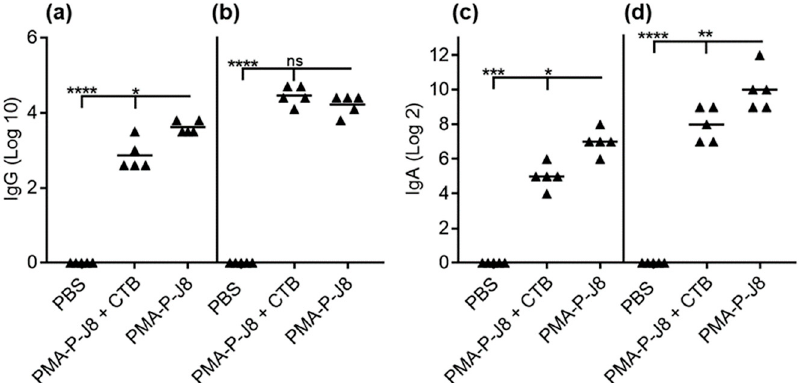
Figure 3. J8-specific antibody response as determined by ELISA. ( a ) J8-specific serum IgG titers after primary immunization; ( b ) J8-specific serum IgG titers after secondary immunization; ( c ) J8-specific serum IgA titers after primary immunization; ( d ) J8-specific serum IgA titers after secondary immunization. Not significant (ns) p > 0.05, (*) p < 0.05, (**) p < 0.01, (***) p < 0.001, (****) p < 0.0001.